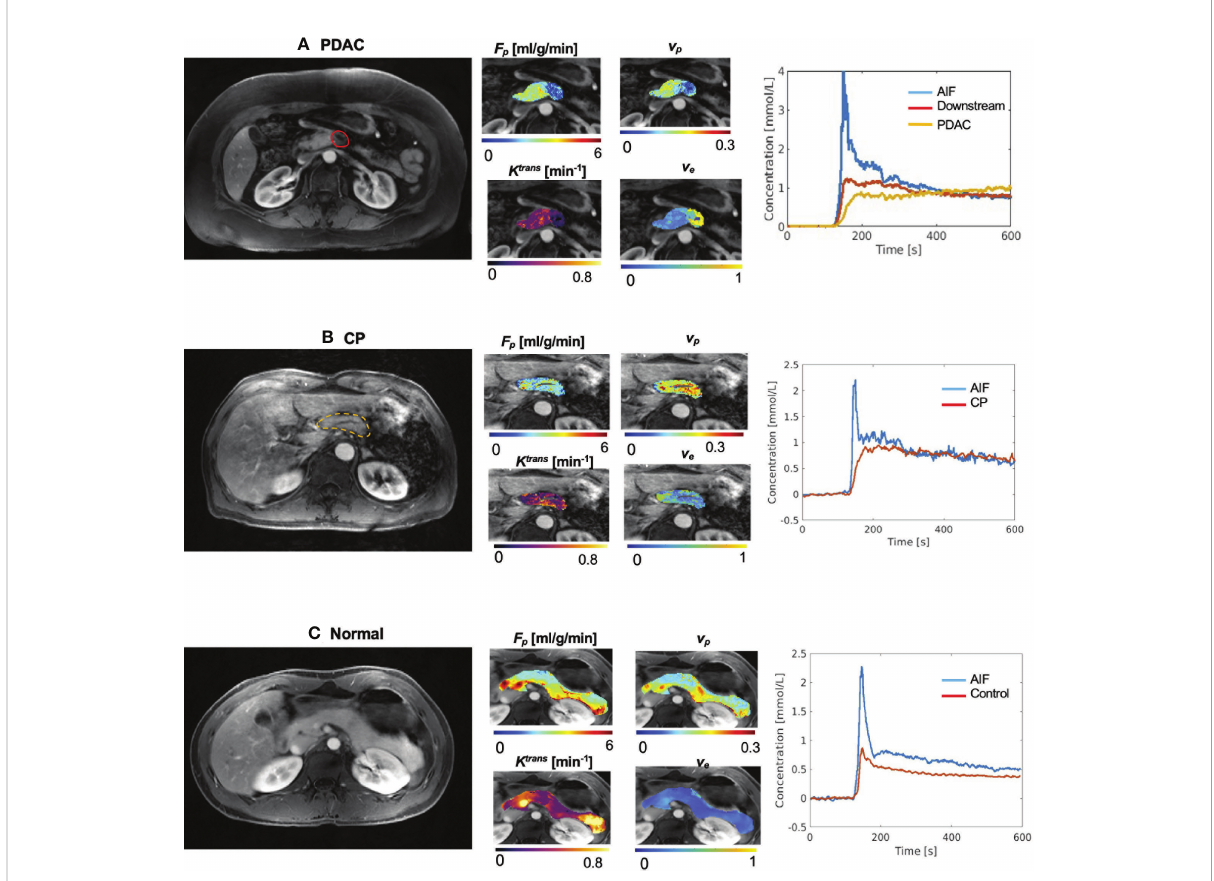
FIGURE 2 Example microcirculation parametric maps. (A) Example maps from 72-year-old patient with PDAC, whose tumor is located at the neck of pancreas. First panel shows a gray-scale Multitasking image at the arterial phase at the center slice of the tumor. The tumor was labeled by the red solid boundary. Downstream was visible in this slice. The second panel shows estimated microcirculation parametric maps. PDAC tumor showed lower F p , lower v p , and elevated v e compared to downstream. The third panel shows the averaged contrast agent concentration curves for blood, PDAC tumor, and PDAC downstream. (B) Example maps from a 65-year-old patient with CP. The pancreas was labeled by the yellow dashed boundary. (C) Representative maps of a 32-year-old subject in the normal control